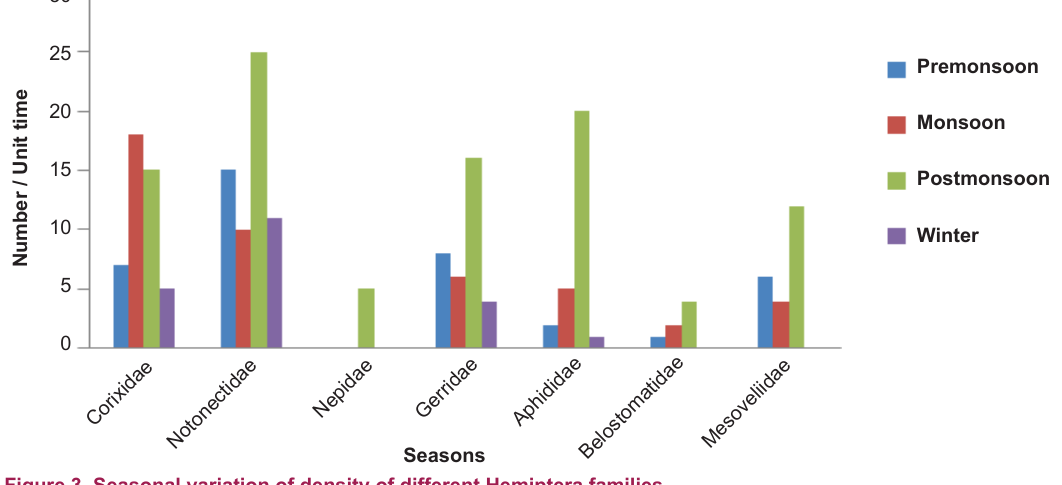
Figure 3. Seasonal variation of density of different Hemiptera